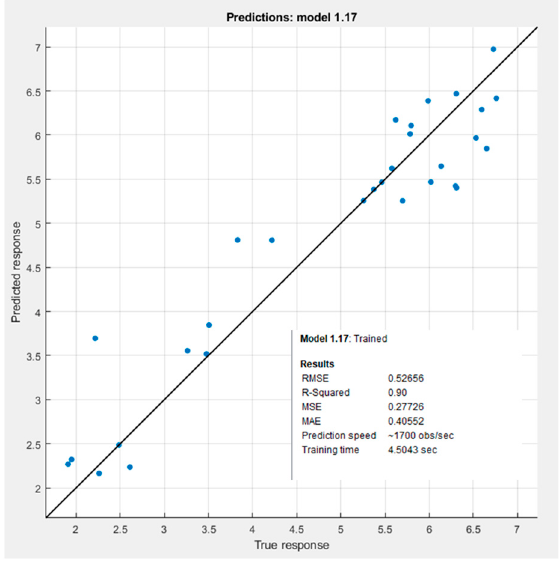
Figure 18. The R-value curves of the MLR structure for fuel consumption. Table 4. Comparison of Simulation, ANN and MLR results to predict the responses.